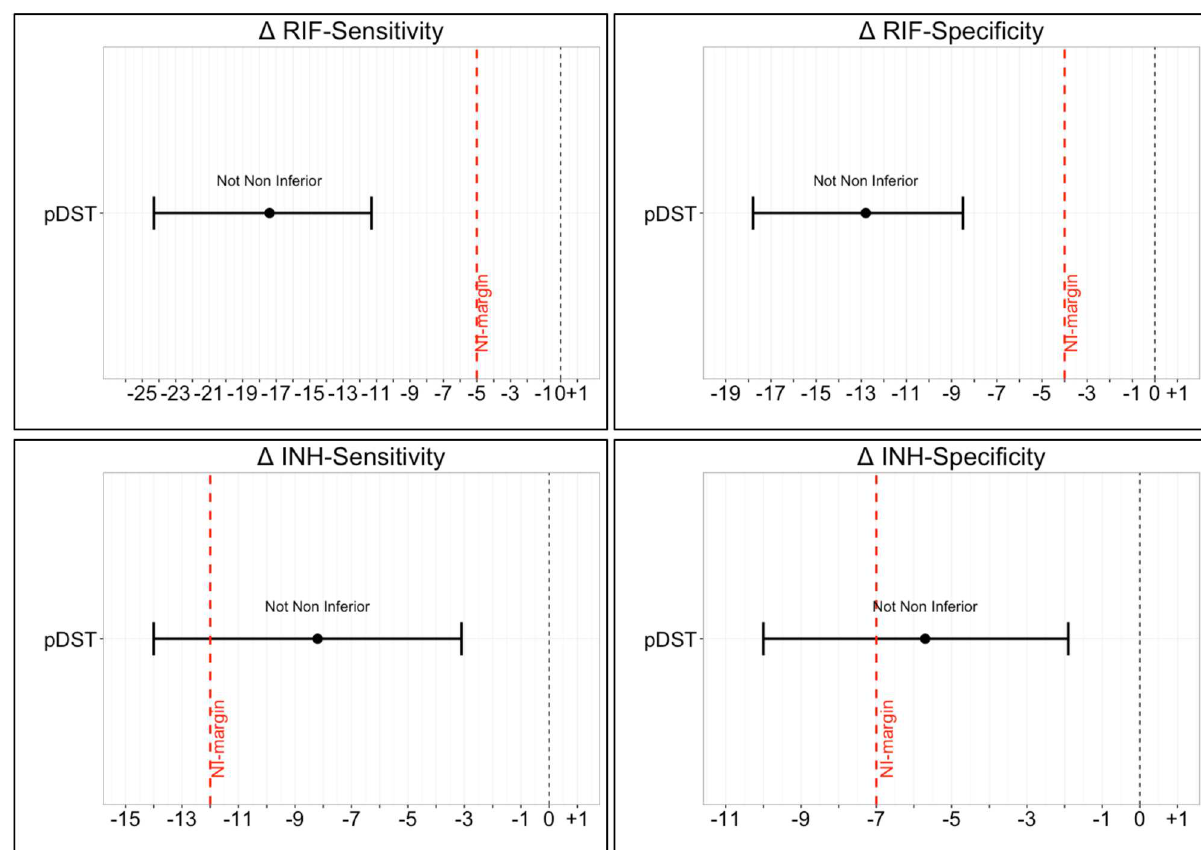
Fig 2. Phase 2 comparative accuracyof the YD line probe assay versus Hain V1 line probe assayon sputum samples. The difference in sensitivity/specificity ( Δ = YD–HainV1) is displayedin the CIs in each plot. The horizontal axis indicatesthe percent difference betweentests. The point in the center of each CI represents the point estimate and whiskers representingthe upper and lower limit of the 95% CIs. The black vertical dotted line (where visible)indicateszero difference in sensitivity/specificity and the red vertical broken line indicatesthe non-inferiority margin. Non-inferiority is demonstrated for a given comparisonif the lower limit of the 95%CI does not cross the red broken line (non-inferiority margin).